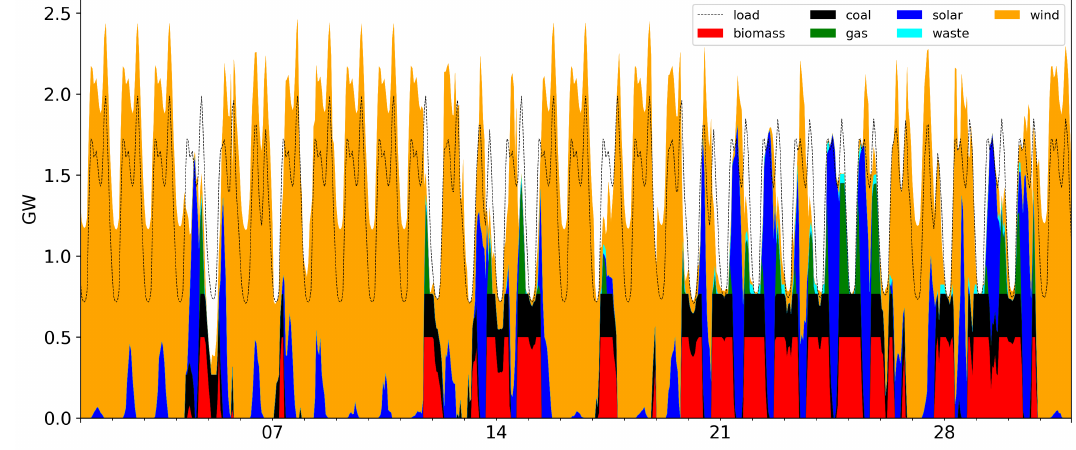
Figure 4. Overall generated power dispatched in March stacked by